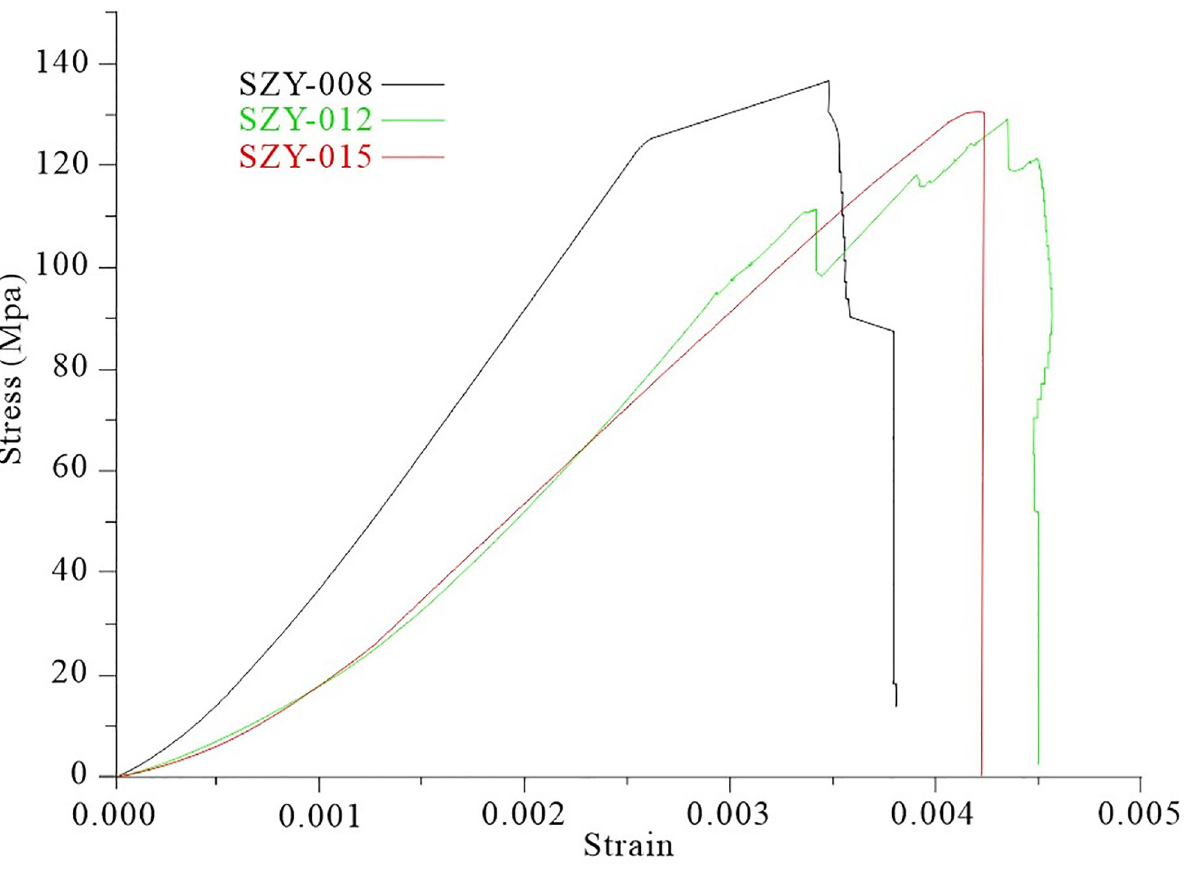
Fig 14. Process curve of rock uniaxial compression in the -570m level of Sizhuang mining area.